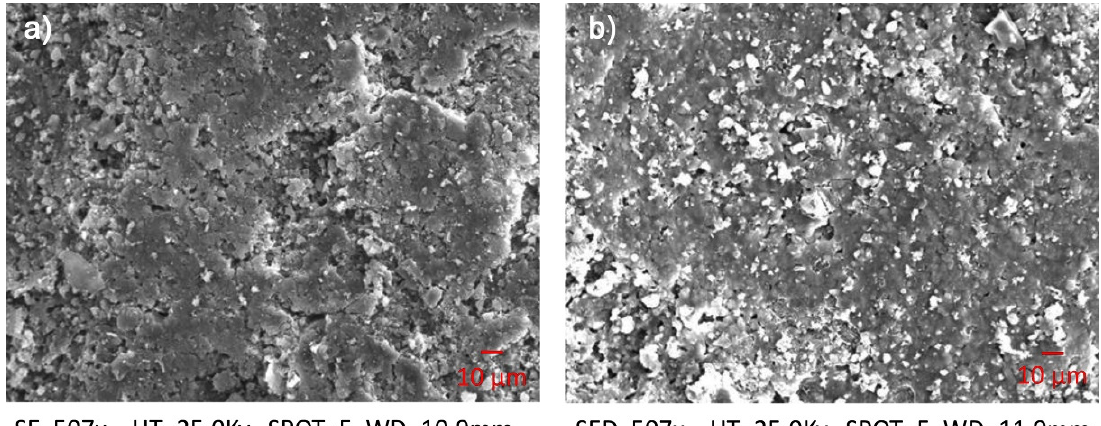
Figure 4. SEM observation of untreated ( a ) and treated brick specimens ( b ). White spots represent TiO 2